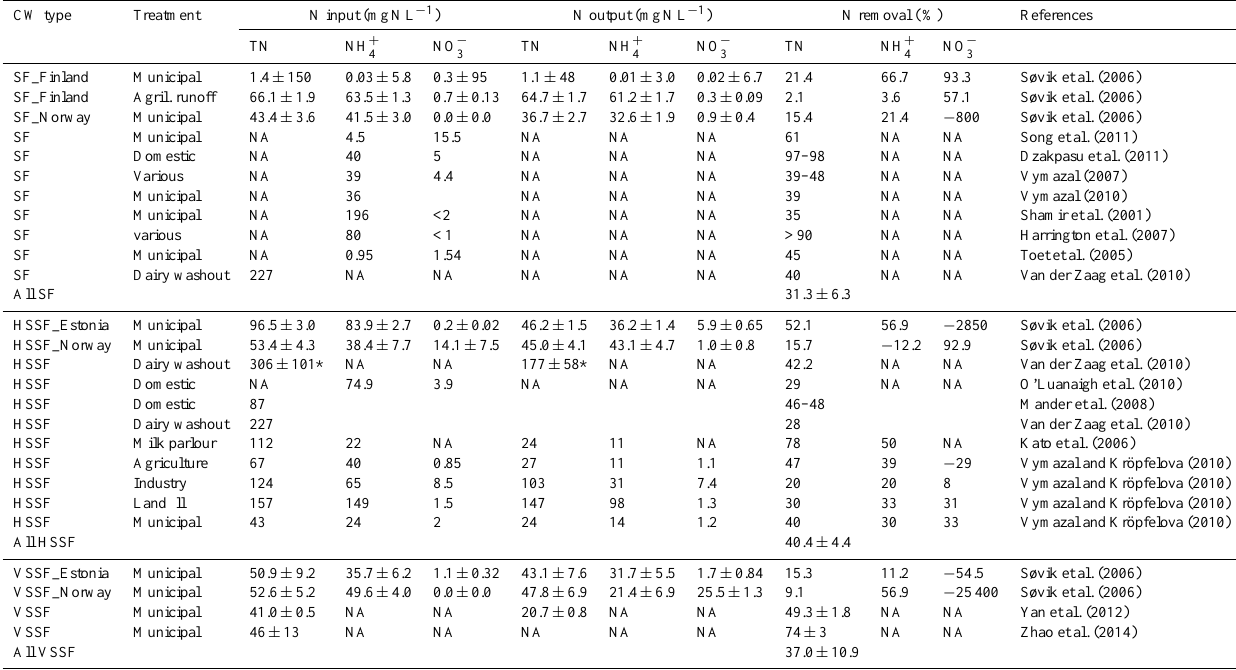
Table 1. TN input (mgNL − 1 ), TN output (TN, mgNL − 1 ), and TN removal (%) in various CWs treating wastewater; average standard error ( ± SE) is presented for TN removal; NA – data not available.